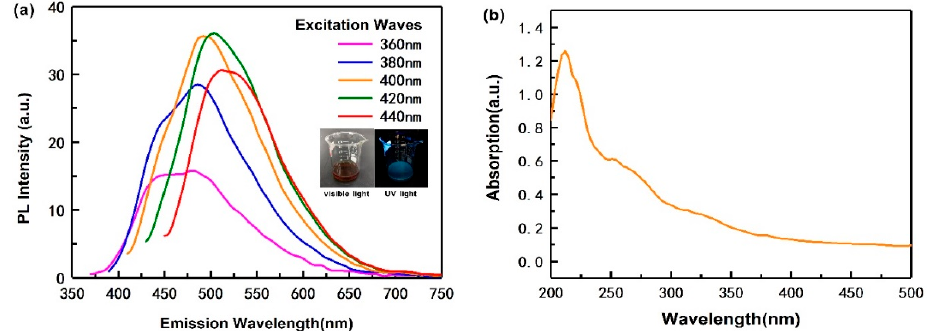
Figure 1. ( a ) Emission spectrum of the as-obtained CQDs at different excitation wavelengths (360–440 nm); ( b ) UV-vis absorption spectra of CQDs.